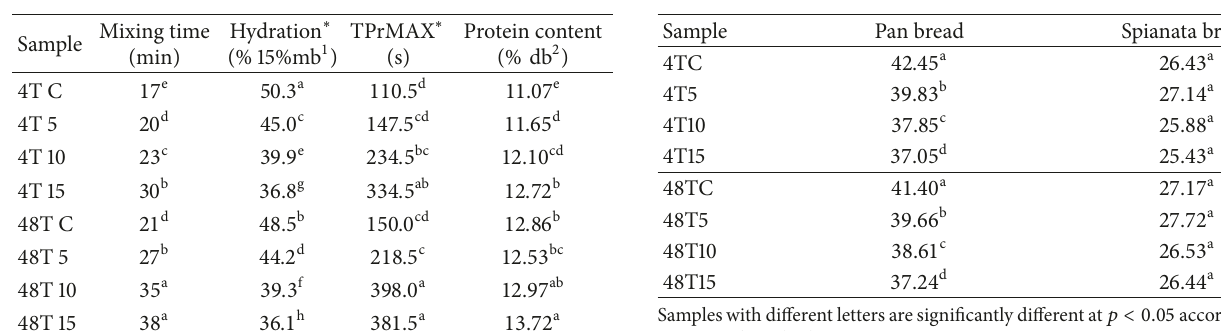
Table 2: Properties of dough samples.